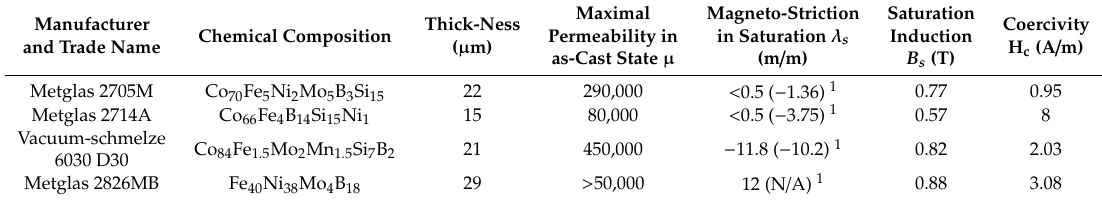
Table 1. Essential parameters of investigated samples, according to the manufacturer’s